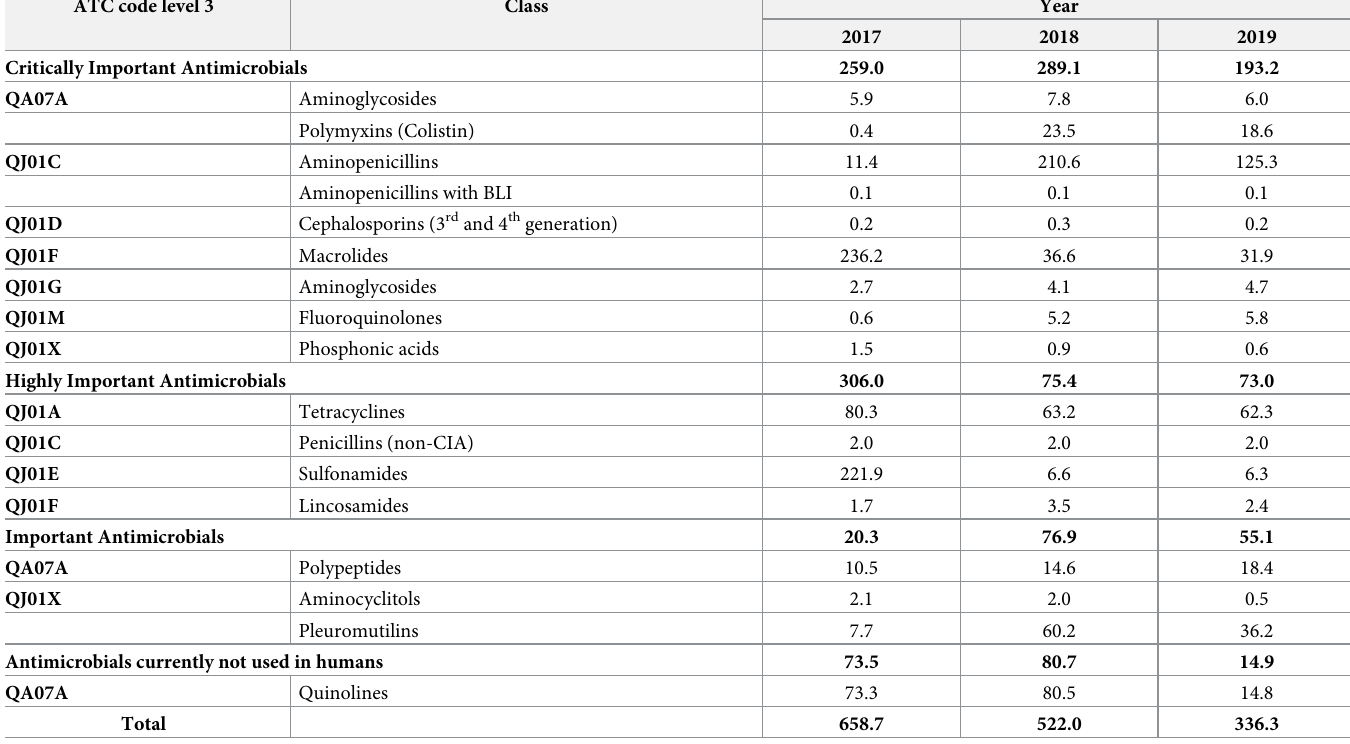
Table 3. Antimicrobial consumption (mg/PCU Thailand ) in food producing animals in Thailand, from 2017 to 2019 (ATC level 3), categorised by Critically important antimicrobials for human medicine [15]. ATC code level